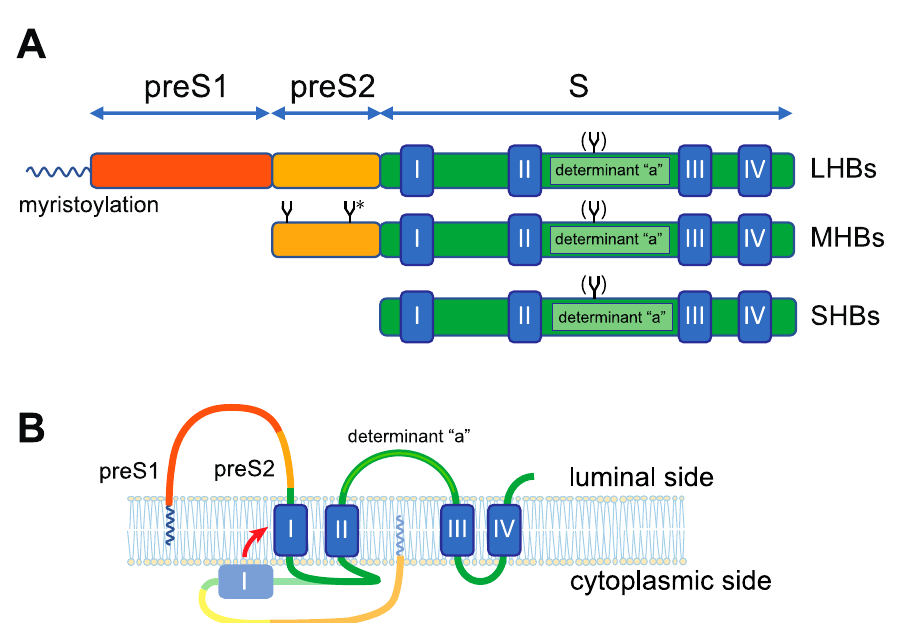
Figure 2. The structure of HBV envelope proteins. ( A ) LHBs contains preS1, preS2 and S domains. Typically, the length is 400 amino acids for most genotypes and 389 amino acids for genotype D. Myristic acid, which is a hydrophobic moiety, is attached at the N-terminus. MHBs contains preS2 and S domains, and SHBs contains only the S domain. There are 4 transmembrane domains (I–IV) in the S domain. Two N-glycosylation sites are indicated as “Y” and the O-glycosylation site for genotypes C and D is indicated as “Y*”. “(Y)” indicates only the part of the proteins that is glycosylated. ( B ) Two-dimensional conformation of LHBs. The myristic acid acts as an anchor and the preS1/preS2 domains in LHBs move between the cytoplasmic side and the luminal side.